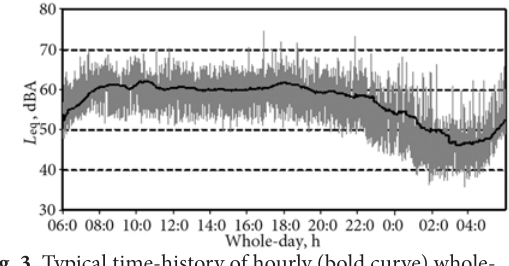
Fig. 3. Typical time-history of hourly (bold curve) whole- day equivalent levels for suburban and urban living areas (Jagniatinskis, Fiks 2014)